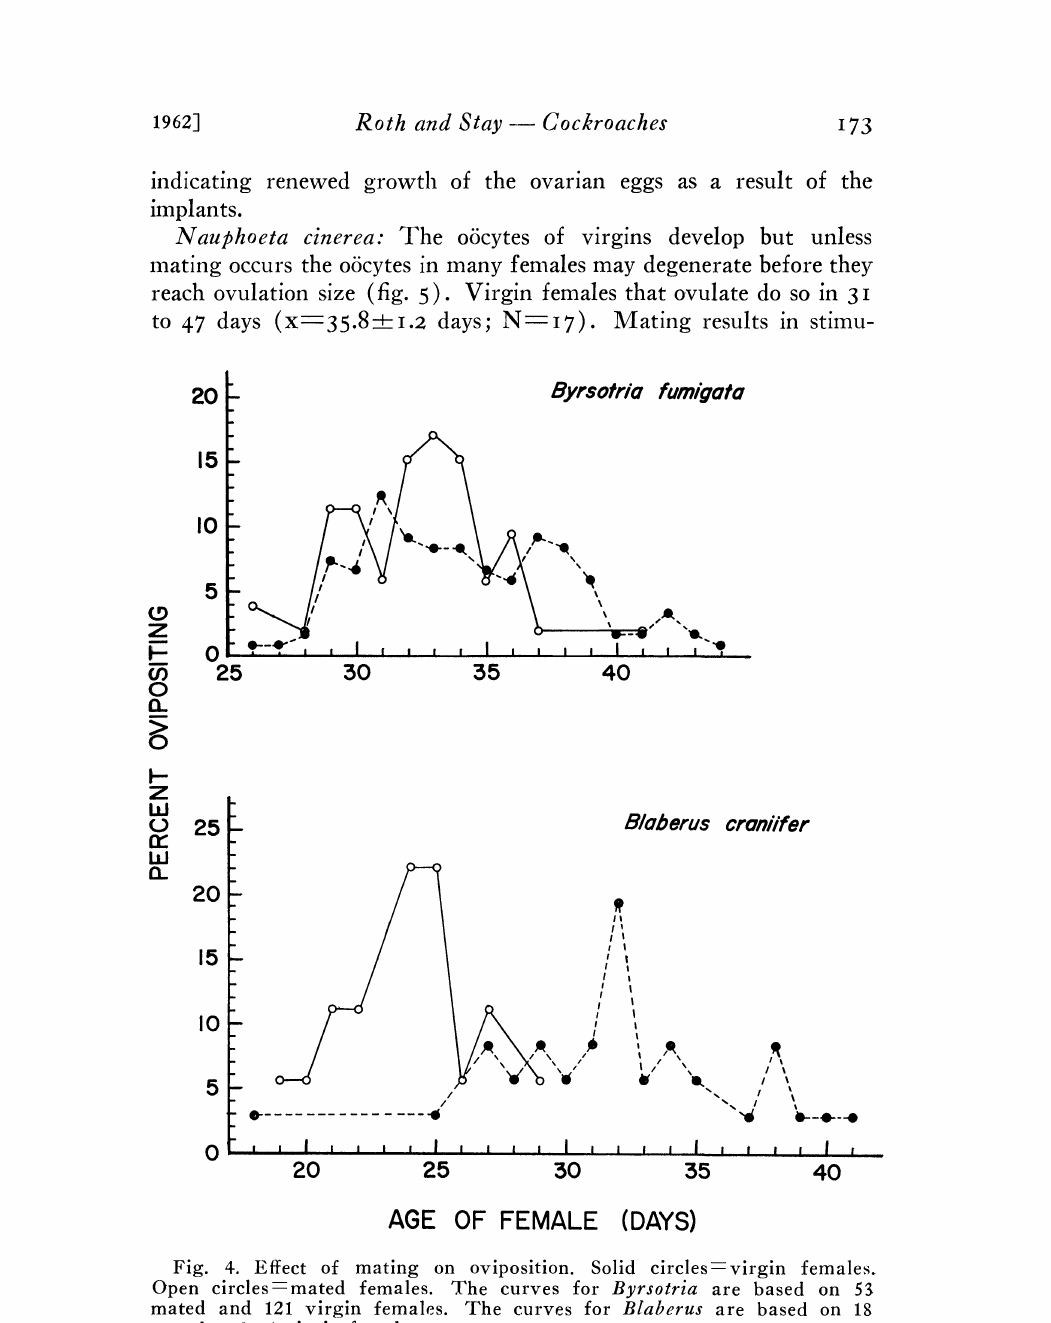
Fig. 4. Efleet of mating on oviposition. Solid circles----virgin females. Open eircleszmated females. The curves for Byrsotria are based on 53 mated and 121 virgin females. The curves for Blaberus are based on 18 mated and 36 virgin